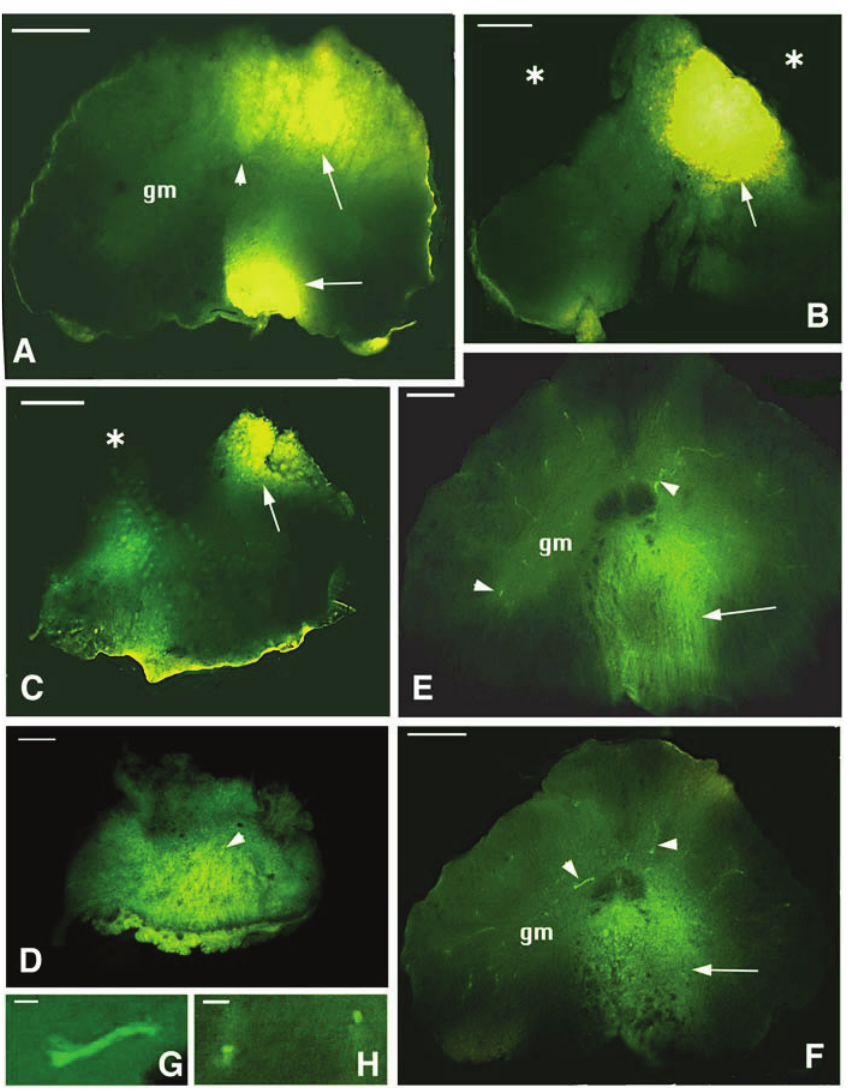
Figure 7. Representative proximal-distal cross-sections of the spinal cord in case 1 experiment (thin bridge tissues with modest recovery) after Dil application. A, section close to the point of Dil application (arrows on most labeled areas). The arrowhead points the position of the central ependymal canal. gm, grey matter. Scale bar, 0.2 mm B, more rostral section within the caudal SC stump (the arrow shows the region with higher tracer-load). Asterisks indicate missing areas of the SC (artifact derived from the vibratome sectioning). Scale bar, 0.15 mm. C, further rostral region preceding the bridge between proximal and distal SC stumps. The arrow indicates the most labeled area. The asterisk indicates some missing tissue due to sectioning. Scale bar, 0.1 mm. D, narrow diameter of the bridge region showing sparse labeled axons (arrowhead). Scale bar, 0.1 mm. E, rostral spinal cord past the bridge area showing a large labeled region in the white matter (arrow) and some cells (arrowheads) in the grey matter. gm, grey matter. Scale bar, 0.15 mm. F, rostralmost region of the SC with labeling in the white matter (arrow) and inside cell bodies (arrowheads) in the grey matter (gm). Scale bar, 0.15 mm. G, detail of a labeled neuron and its likely axonal elongation. Scale bar, 10 (cid:2) m. H, other two small neurons present in the intermediate region of the grey matter. Scale bar, 20 (cid:2)